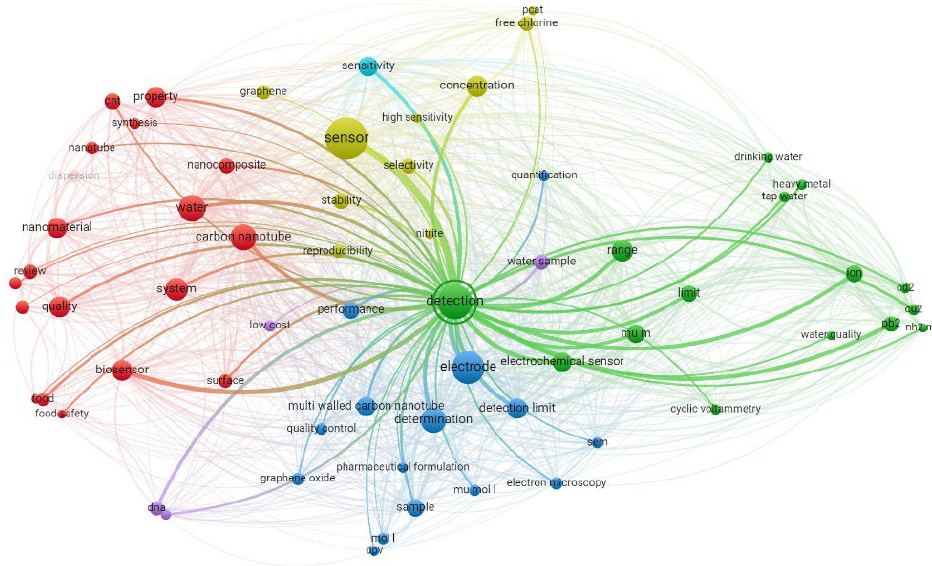
Figure 6. Cluster 2 network visualization. Table 5. Cluster 2 keywords and occurrences.